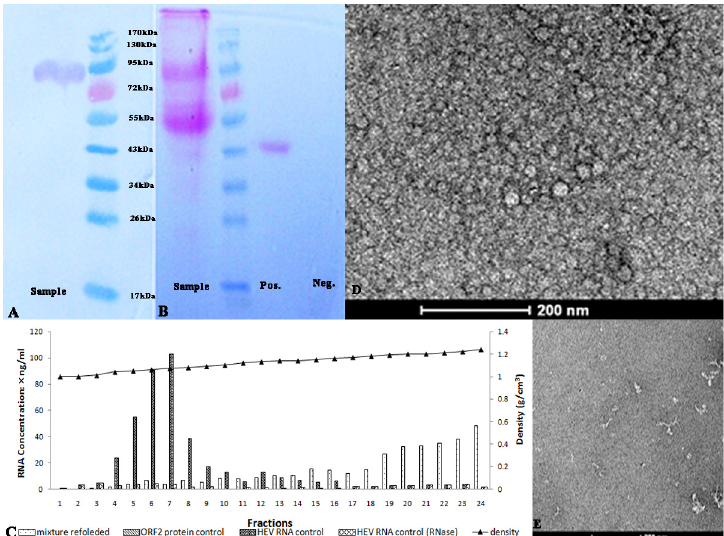
Fig 4. Analysis of the ORF2 protein from the cell culture supernatant. (A) Western blotting of the protein using an anti-ORF2 MAb. (B) The glycoprotein staining of the SDS-PAGE gel. The sample containsthe same magenta band as the positive control and the negative control has no band. (C) The RNA content in density- gradient fractions of the RNA-ORF2 binding product and controls. The X-axis is the fraction number, the left Y-axis is the HEV RNA content andthe right Y-axis is the density of the fraction.(D) and (E) Transmission electron microscopy of the RNA-ORF2 binding product (D) and ORF2 protein without HEV RNA(E) stained with uranyl acetate.The scale bar indicates 200